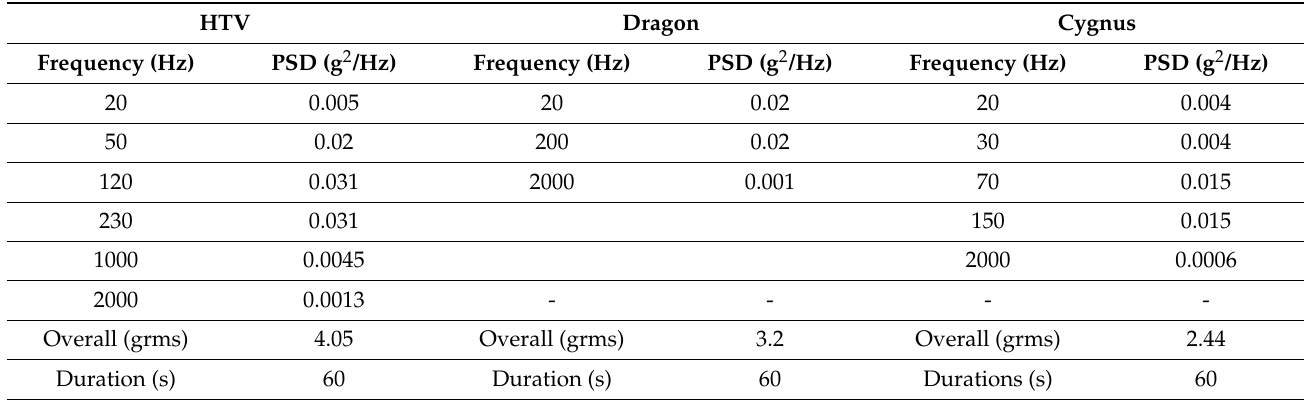
Table 17. Possible random vibration testing profiles